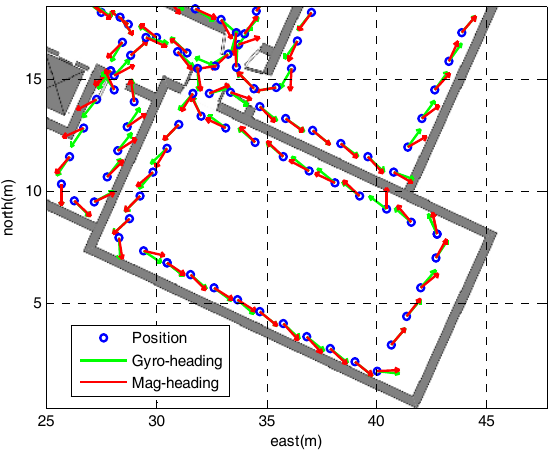
Figure 11. The heading results of the first loop using the proposed method.